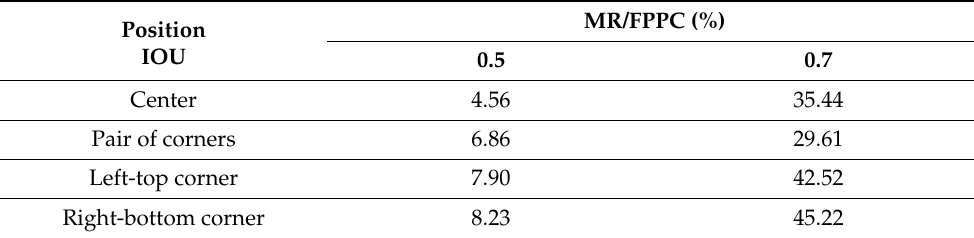
Table 1. Comparisons of finding different points each time as a high-level semantic feature.